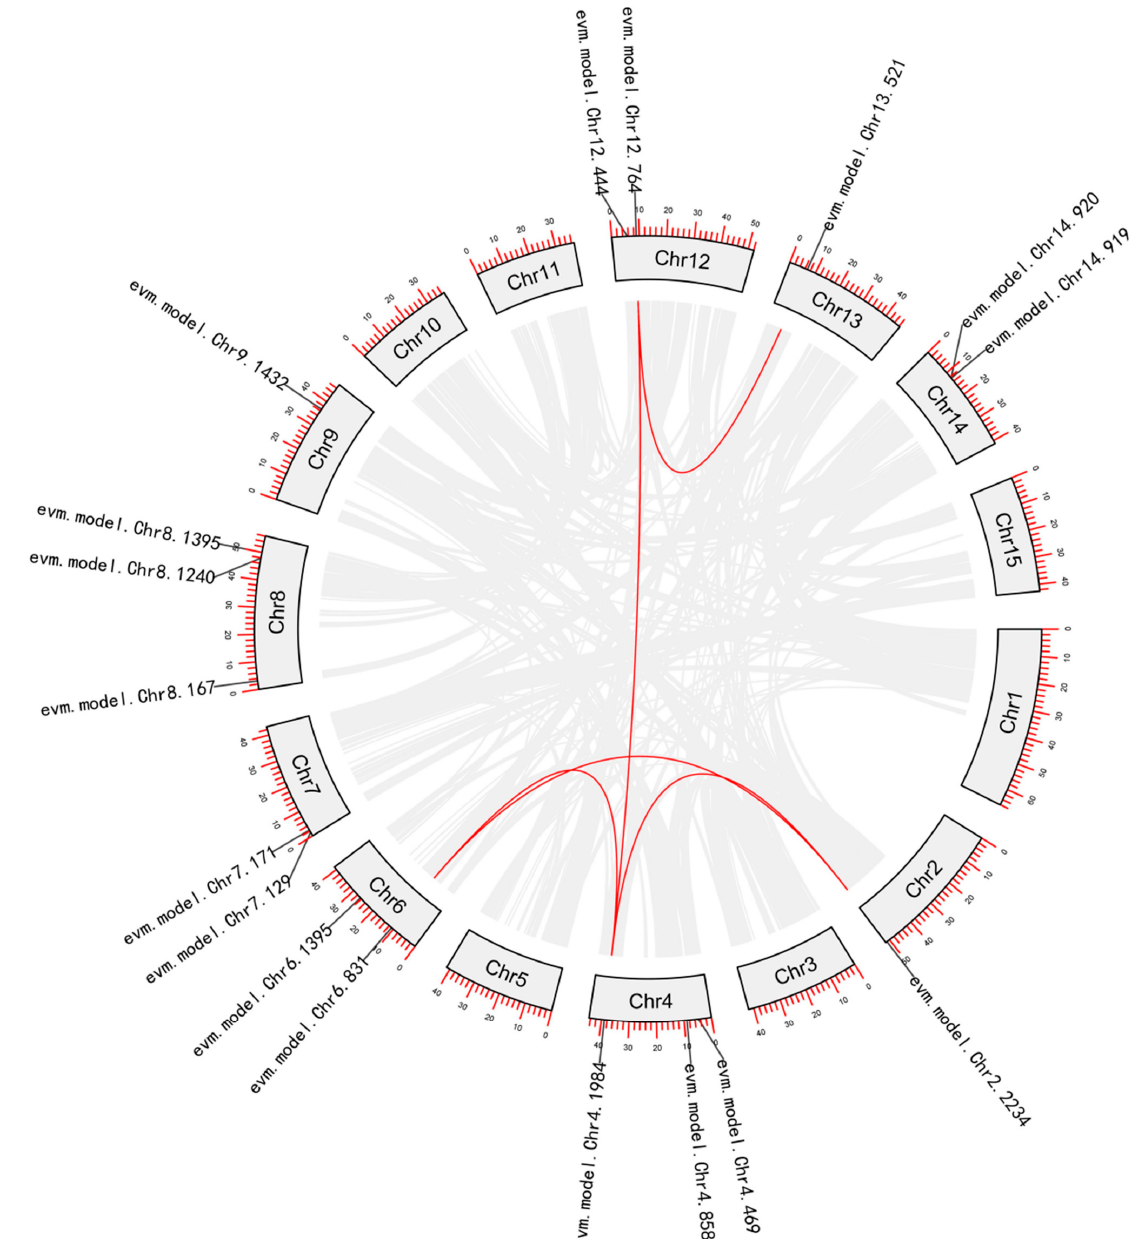
Figure 10. Distribution and duplication of DolSBP s. Gray lines represent the chromosomes of D. oleifera . The scales on the chromosomes represent the chromosome length. The red lines indicate duplicated DolSBP gene pairs.